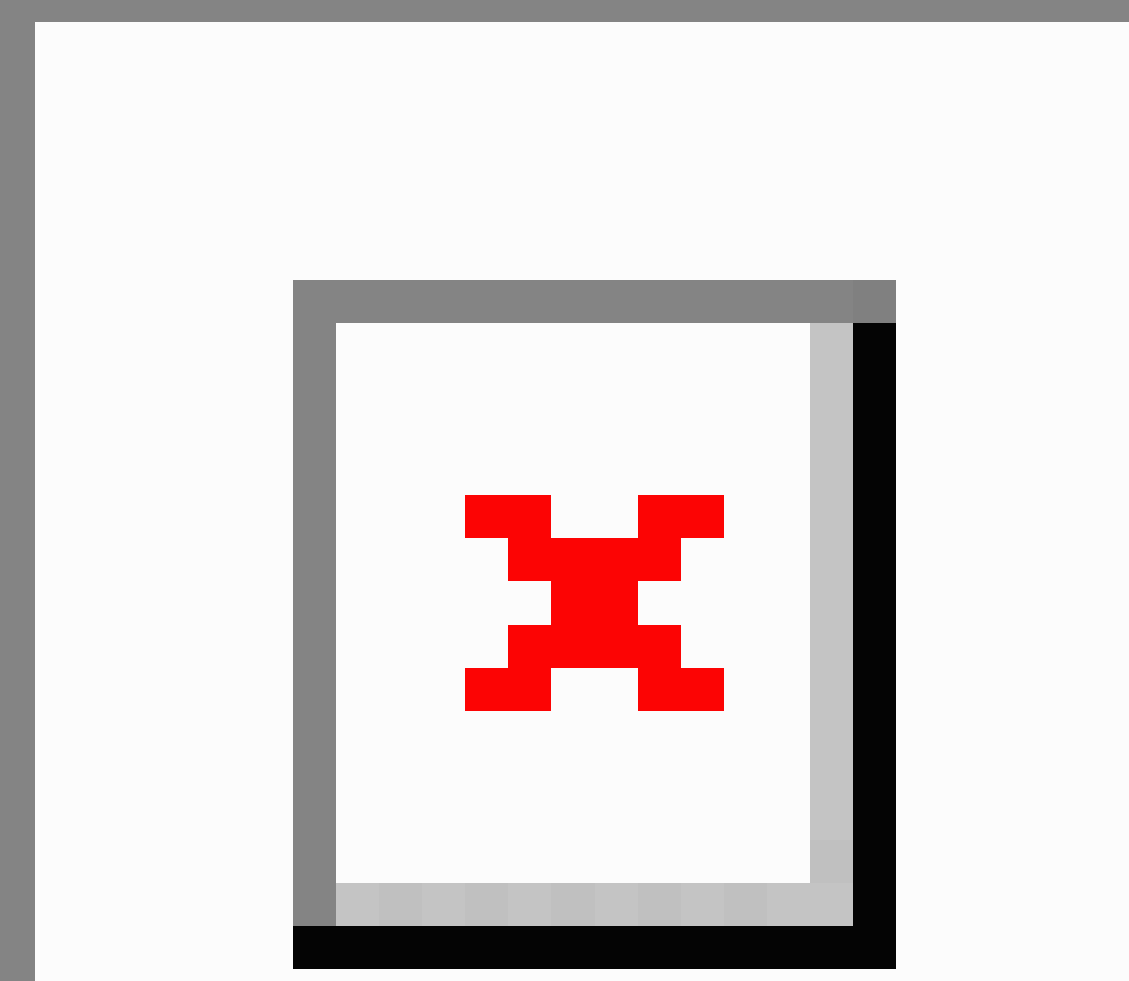
Figure 7. Daily life versus emotional states of person 2 (worst case). The x-axis plots 288 windows per day, and the y-axis plots the number of days in the data collection period of person 2. The color-coded regions represent (a) spatial contexts, (b) activities, and (c) emotional states in each window over the period of data collection (8 days). The white regions represent missing